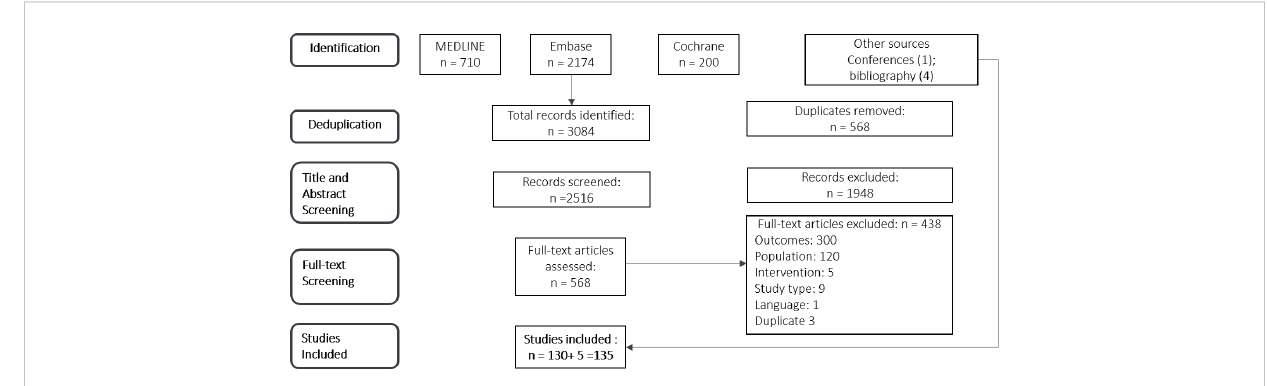
FIGURE 1 PRISMA fl ow-chart of study selection n, number of